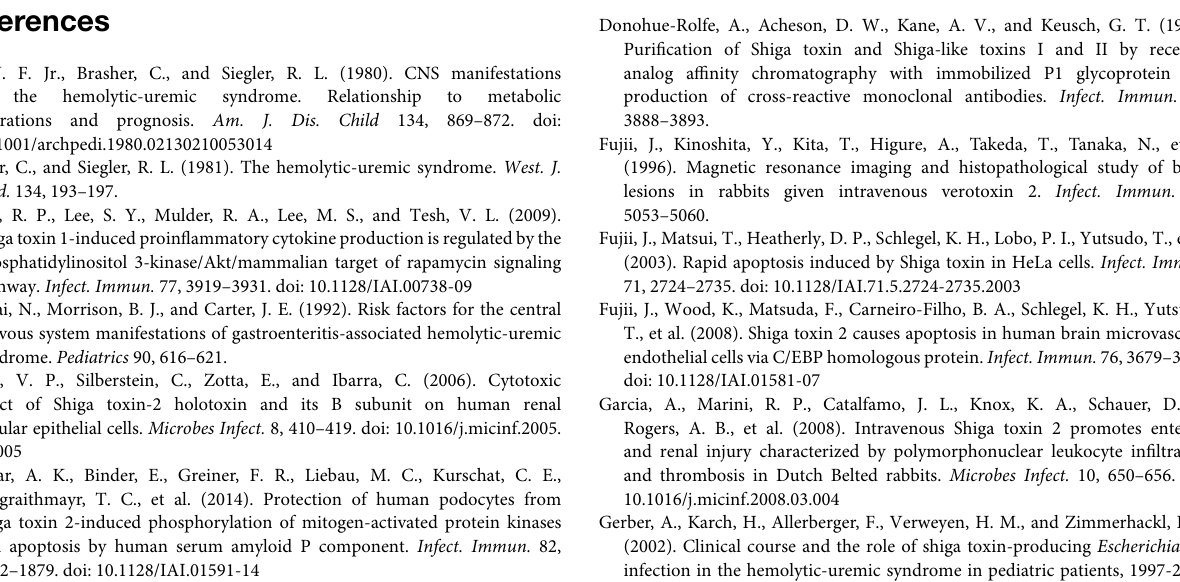
Supplementary Video S2 | 3D STORM-TIRF yellow cluster depth view movie. The distribution of the molecules in Supplementary Video S1 is color coded according to the depth color